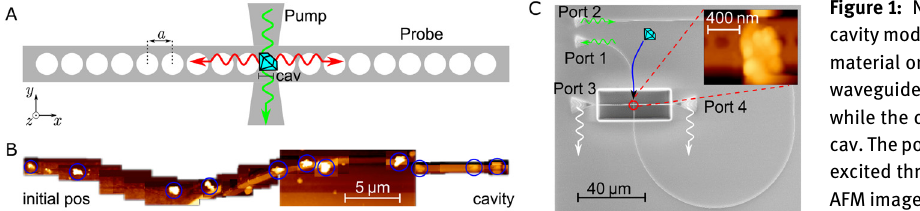
Figure 1: Nanopositioning of ND within cavity mode. A The periodic change a of the material on both sides of the probe waveguide lead to a photonic band gap, while the cavity is formed by the distance cav.ThepositionedNDcanbeevanescently excited through the pump waveguide.